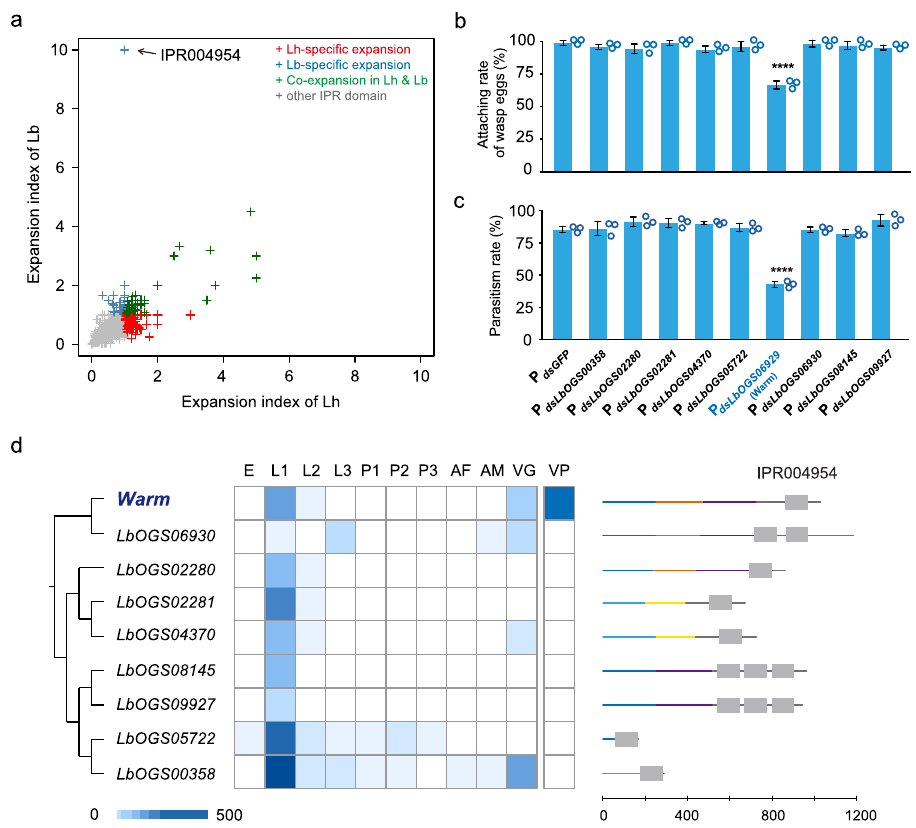
Fig. 4 Unique expansion of mucin-binding domain-containing genes in Lb. a Expansion and contraction of all annotated InterPro domains (IPRs) between the Lh and Lb genomes. The expansion index indicates the ratio of identi fi ed IPRs in the corresponding species to the highest number in all other hymenopteran species. See detailed information in Supplementary Data 6. b The attachment rate of wasp eggs in host larvae that were parasitized by Lb depleted of each of the nine mucin-binding domain-containing genes via RNAi treatment. dsGFP -treated Lb (P dsGFP ) was used as a control. Left to right: n = 81, 99, 99, 99, 86, 75, 76, 83, 102, and 86 biologically independent host larvae. Three biological replicates were performed and shown as side dots. Data represent the mean ± SD. Signi fi cance was determined by two-tailed unpaired Student ’ s t test (P dsLbOGS00358 : P = 0.1196; P dsLbOGS02280 : P = 0.1387; P dsLbOGS02281 : P = 0.9661; P dsLbOGS04370 : P = 0.0569; P dsLbOGS05722 : P = 0.3264; P dsLbOGS06929 : P = 0.0001; P dsLbOGS06930 : P = 0.8246; P dsLbOGS08145 : P = 0.3972; P dsLbOGS09927 : P = 0.077; **** P < 0.001). c Parasitism rates in D. melanogaster host larvae attacked by the above dsRNA-treated Lb wasps. Left to right: n = 76, 62, 78, 86, 99, 83, 58, 79, 152, and 86 biologically independent host larvae. Three biological replicates were performed and shown as side dots. Data represent the mean ± SD. Signi fi cance was determined by two-tailed unpaired Student ’ s t test (P dsLbOGS00358 : P = 0.8317; P dsLbOGS02280 : P = 0.0791; P dsLbOGS02281 : P = 0.1182; P dsLbOGS04370 : P = 0.0365; P dsLbOGS05722 : P = 0.6201; P dsLbOGS06929 : P = 2.9e-5; P dsLbOGS06930 : P = 0.927; P dsLbOGS08145 : P = 0.2255; P dsLbOGS09927 : P = 0.0721; **** P < 0.001). d Expression heatmap of nine mucin-bd-containing genes. Samples correspond to those in Fig. 1. Gene architectures are shown on the right. Lines represent coding sequences; those in the same color indicate homologous segments across genes (peptide identity to Warm >50%), while those in lighter color indicate potential homologous segments of poorer identity (<50% to Warm ). Gray boxes represent IPR004954. Source data are provided as a Source data fi